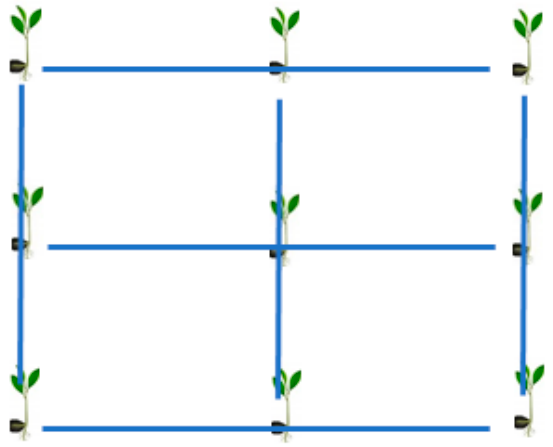
Figure 2. Rectangular pattern of planting.